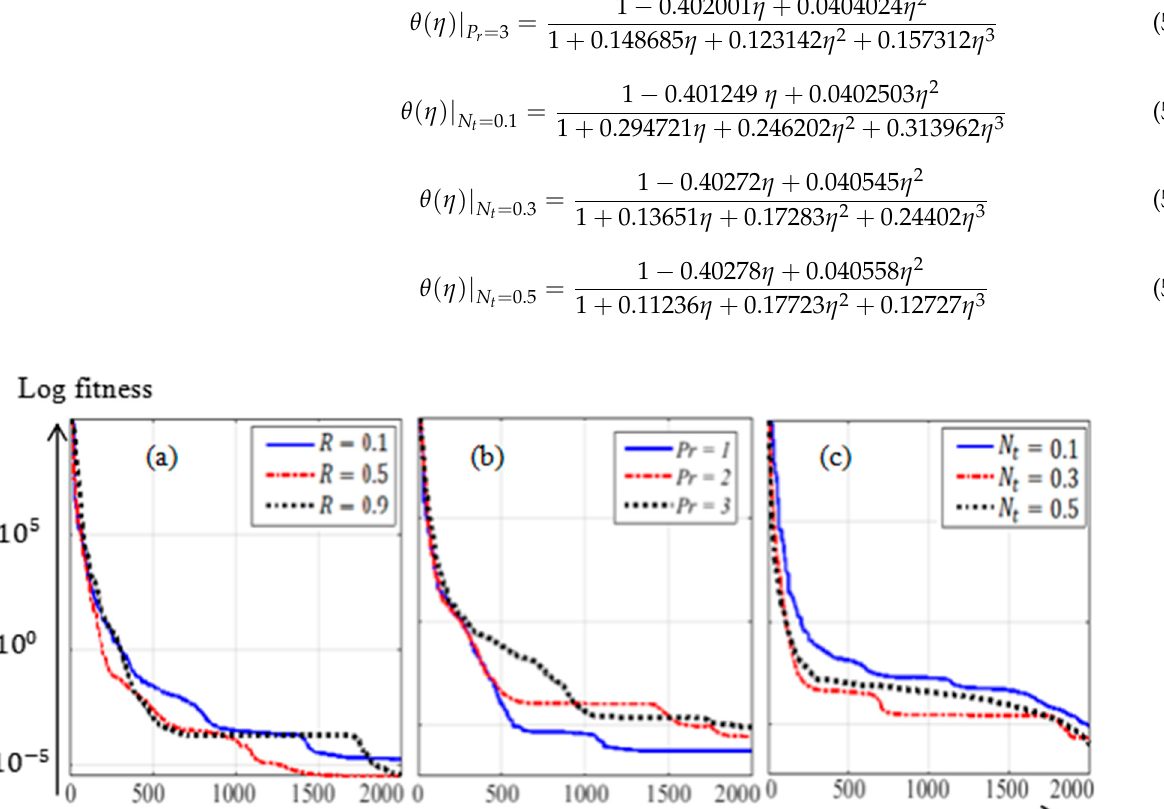
(53) The impact of radiation parameter ( 𝑅 ) on temperature fi eld is plo tt ed in Figure 9. The physical behavior of fl uid is greatly a ff ected by variations in the thermal radiation parameter. The incremental values of the parameter of thermal radiation support inter- nal heat energy during the fl ow. Due to this, the temperature pro fi le is driven to in- crease. The graphical view of impact of Prandtl number ( 𝑃𝑟 ) on temperature pro fi le is presented in Figure 10. It can be observed that the increasing values of 𝑃𝑟 have reverse in fl uence on temperature pro fi le. Figure 11 demonstrates that the increase in values of thermophoresis parameter ( 𝑁 (cid:3047) ) impacts the temperature fi eld.